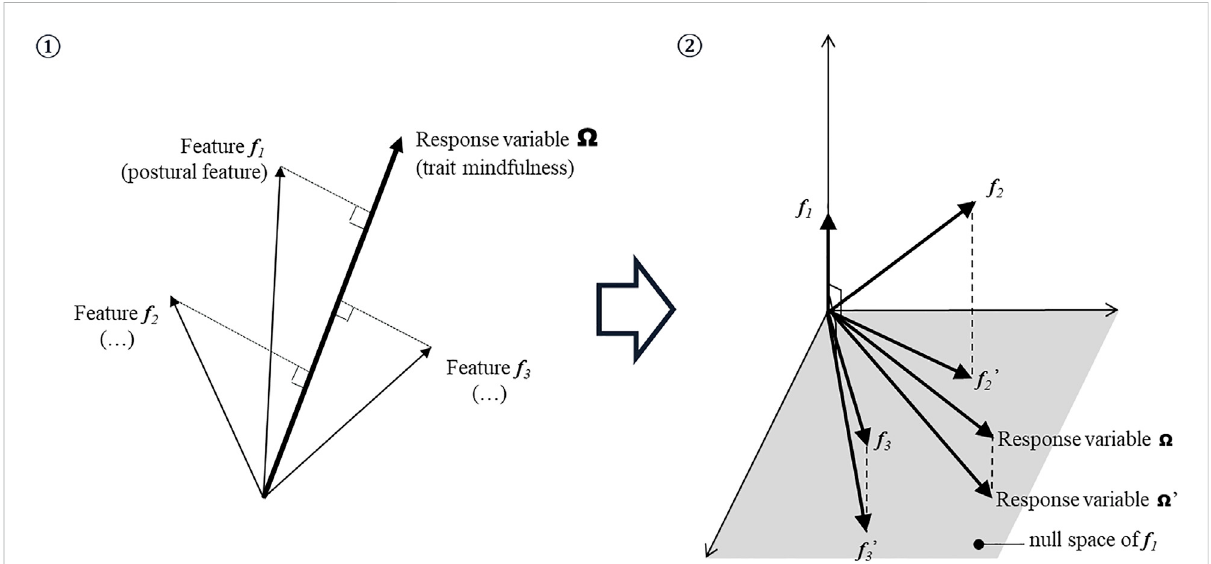
FIGURE 2 An illustration of the Orthogonal Forward Regression (OFR) algorithm for variable ranking. The algorithm operates iteratively: 1) all candidate variables are ranked according to their correlations to the response variable, namely the squared cosine of the angle between the candidate variable and theresponse variable; themostcorrelated variable (with themaximum squared cosine) is ranked fi rst; 2)all remainingcandidate vectors and the responsevariableareorthogonalizedwithrespectto the fi rstvector,inordertoeliminatethecontribution ofthelatter totheresponsevariable; then, the fi rst candidate variable is stored and removed from the set of candidate variables, and the algorithm iterates with the remaining orthogonalized candidate variables and the response variable, until all candidate variables are